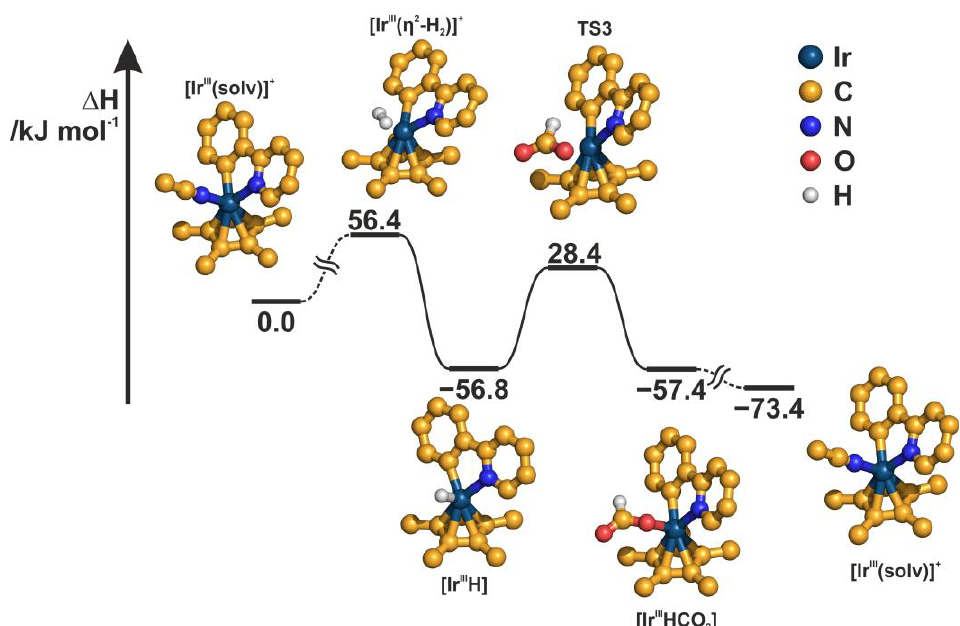
Figure 6. Reaction enthalpy profile for the catalyst M1 in MeCN using DBU as a base.